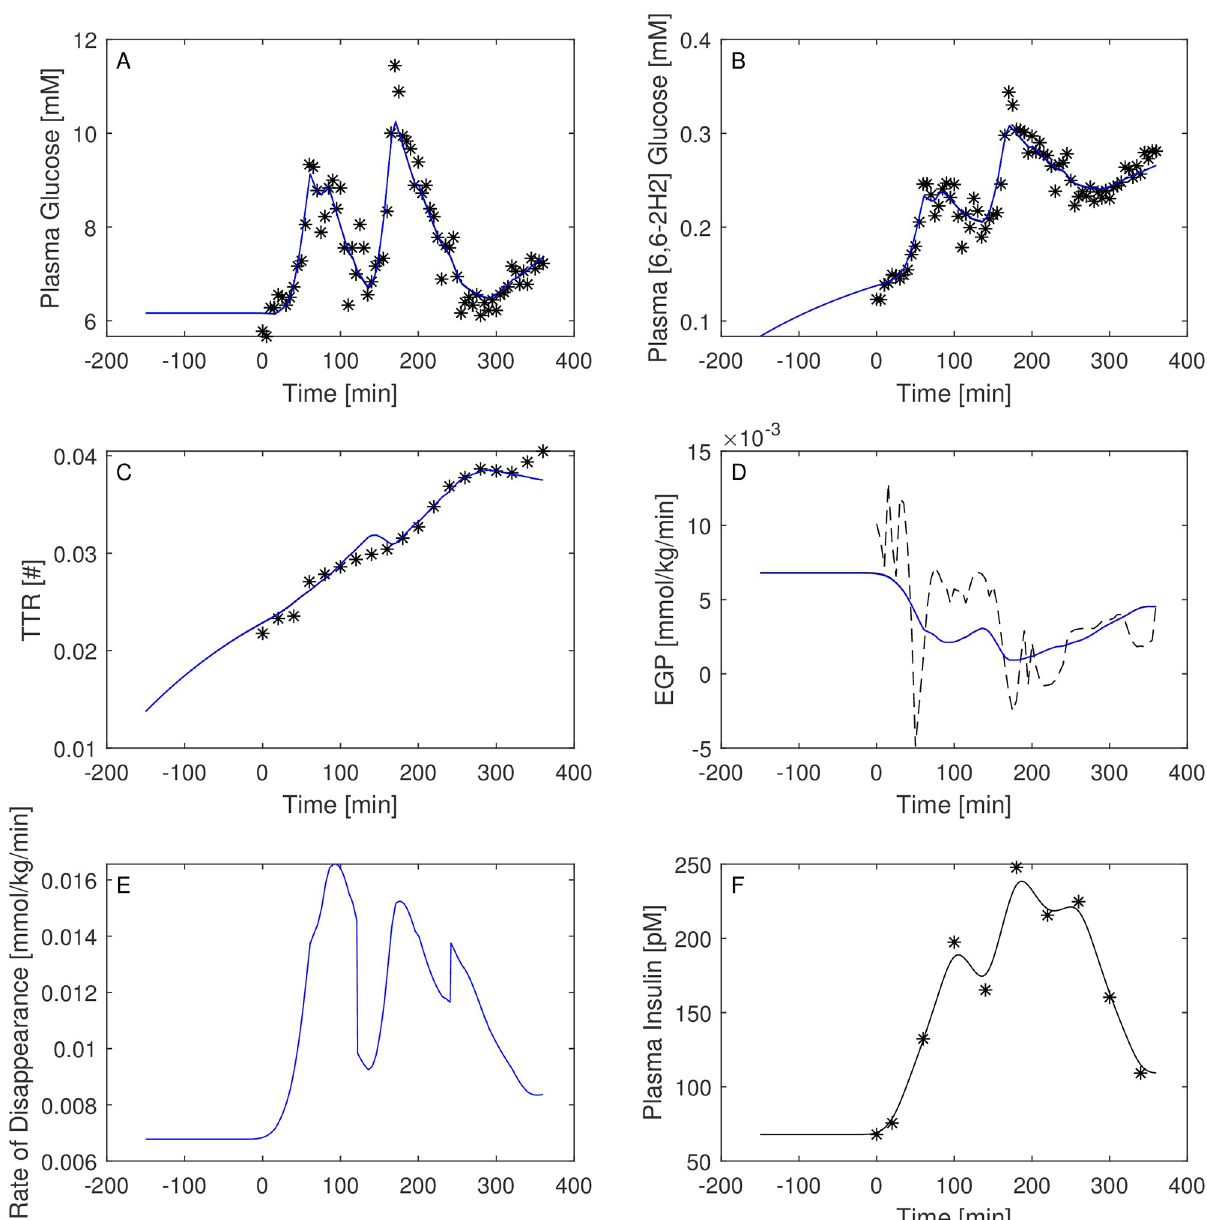
Fig 5. Predictions for Subject 3. Observed (asterisks) and predicted (line) variables over time (T2DM subject). EGP: Endogenous Glucose Production; TTR: Tracer to Tracee ratio. Plasma glucose concentration (Panel A); Plasma [6, 6-2H2]glucose (Panel B); TTR (Panel C); EGP (Panel D), dashed line is the predicted EGP with the Steele model; Rate of disappearance (panel E); Plasma Insulin concentrations (Panel F). All the observed points refer to data measured on day 2. Plasma glucose concentrations (panel A) are derived from the glucose intra-venous infusion to match plasma glucose observations from the OGTTs of day 1. Black lines in panels A, B, C, D and E are model predictions from WLS estimation procedure; blue lines derive from the estimation approach which uses autocorrelated